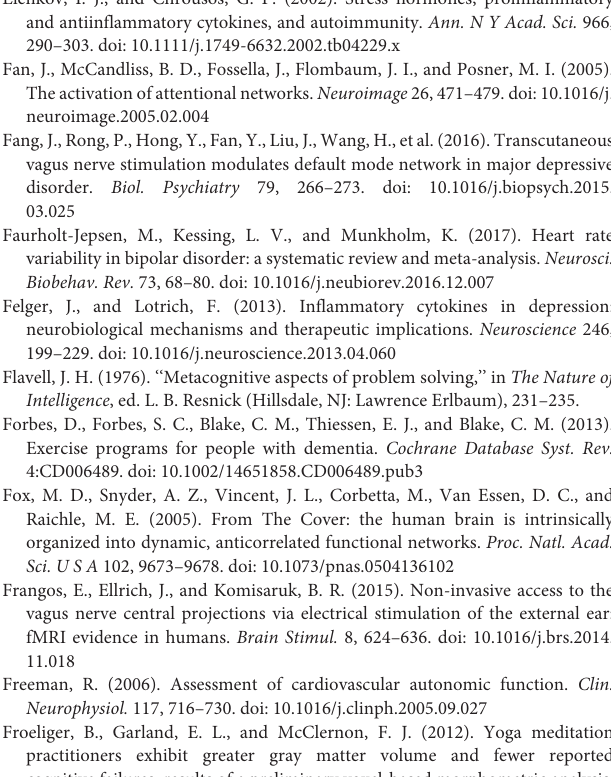
practitioners exhibit greater gray matter volume and fewer reported cognitive failures: results of a preliminary voxel-based morphometric analysis.